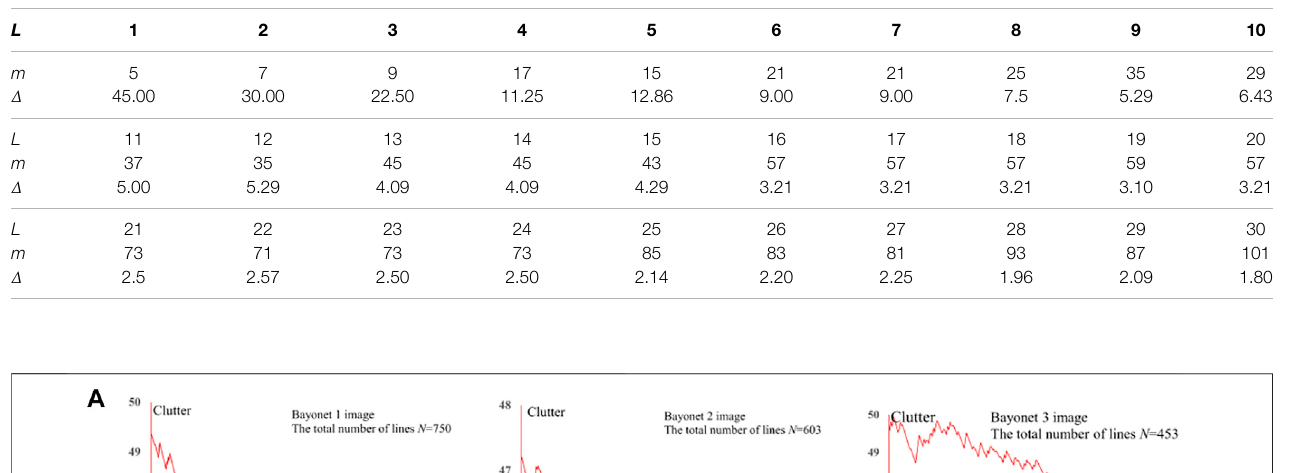
TABLE 1 | Relation between segment length and angle resolution.